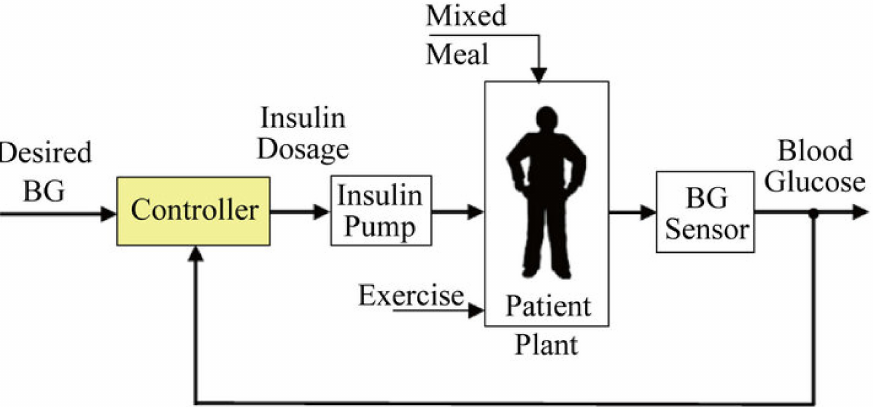
Figure 1. Conceptual diagram of closed-loop control